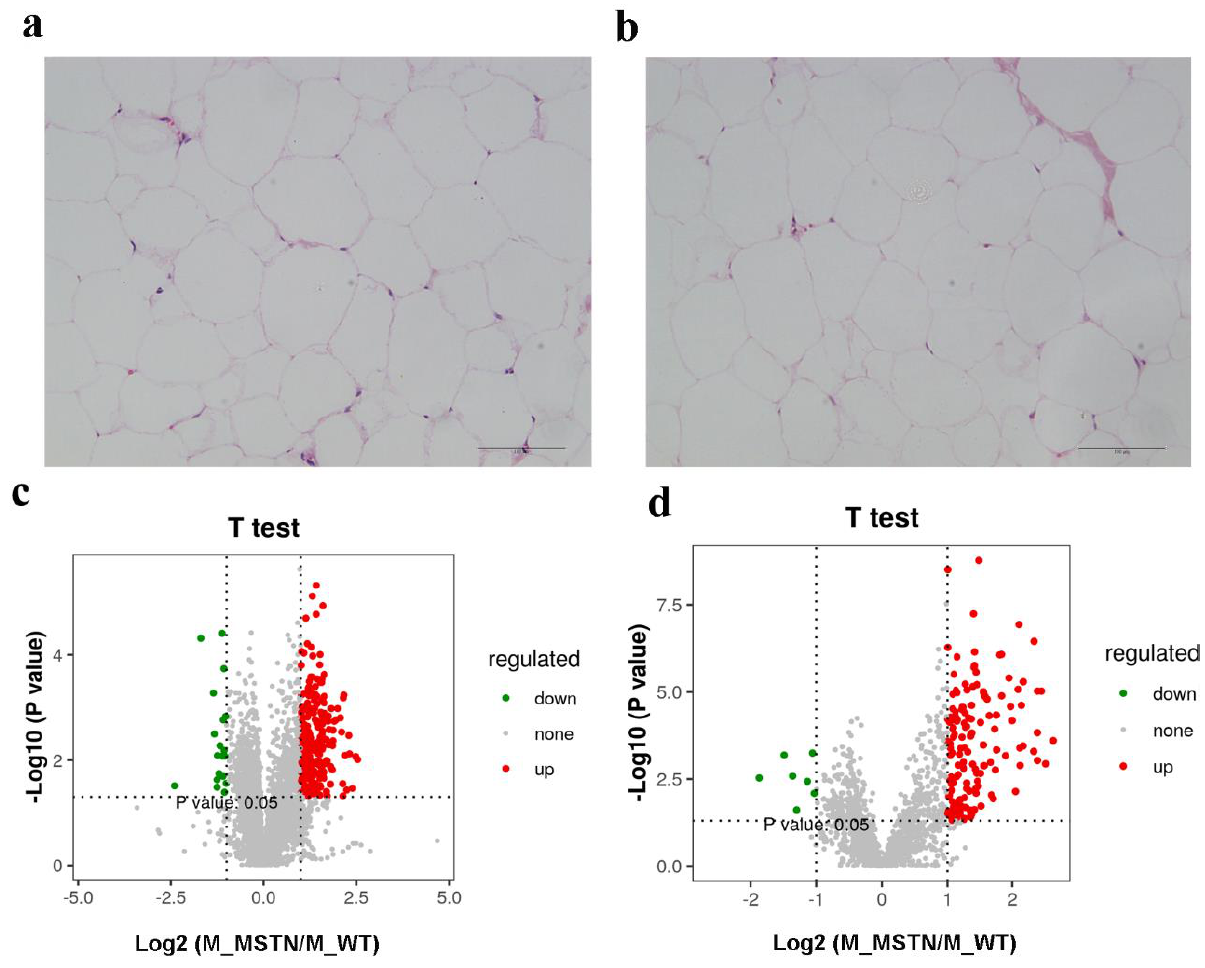
Figure 1. The decreased expression of MSTN altered the lipid content of subcutaneous fat. ( a ) HE staining of adipose tissue from MSTN +/− pigs; ( b ) HE staining of adipose tissue from WT pigs; ( c ) Volcano plot of lipid metabolites in positive ion mode; ( d ) Volcano plot of lipid metabolites in negative ion mode.